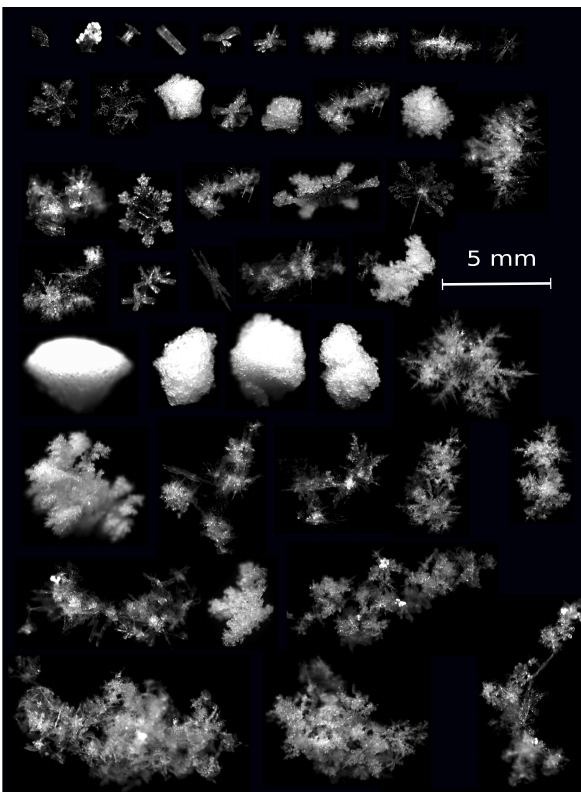
Fig. 2. A sample of MASC images of hydrometeors in free fall taken using a 35mm lens on a 5MP camera.